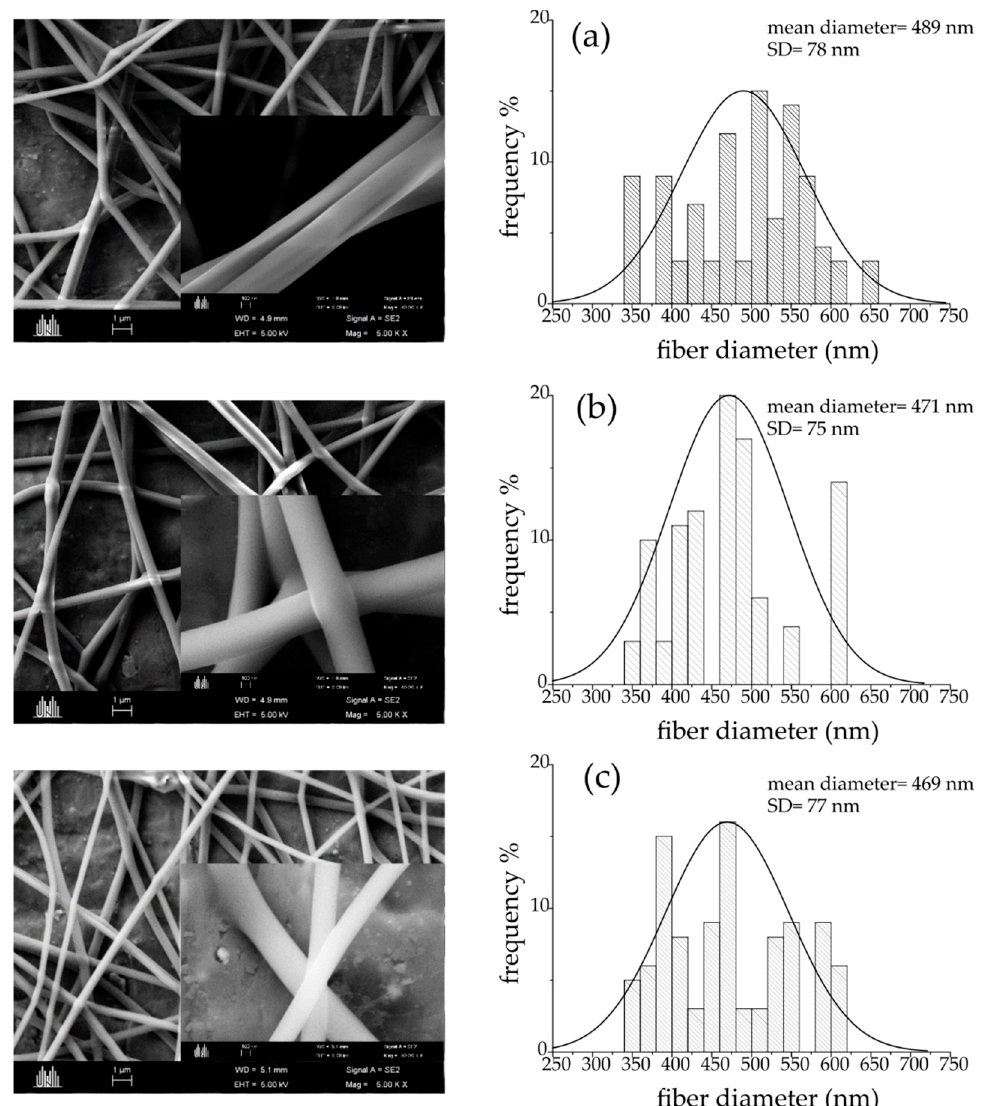
Figure 2. Scanning electron microscopy (SEM) of the monolithic PVA and PVA / TSC5, and the core–shell PVA/TSC10-PVA fibers ( left ) and their diameter distributions ( right ) with different TSC content ( a ) PVA, ( b ) PVA/TSC5, and ( c ) PVA/TSC10-PVA.